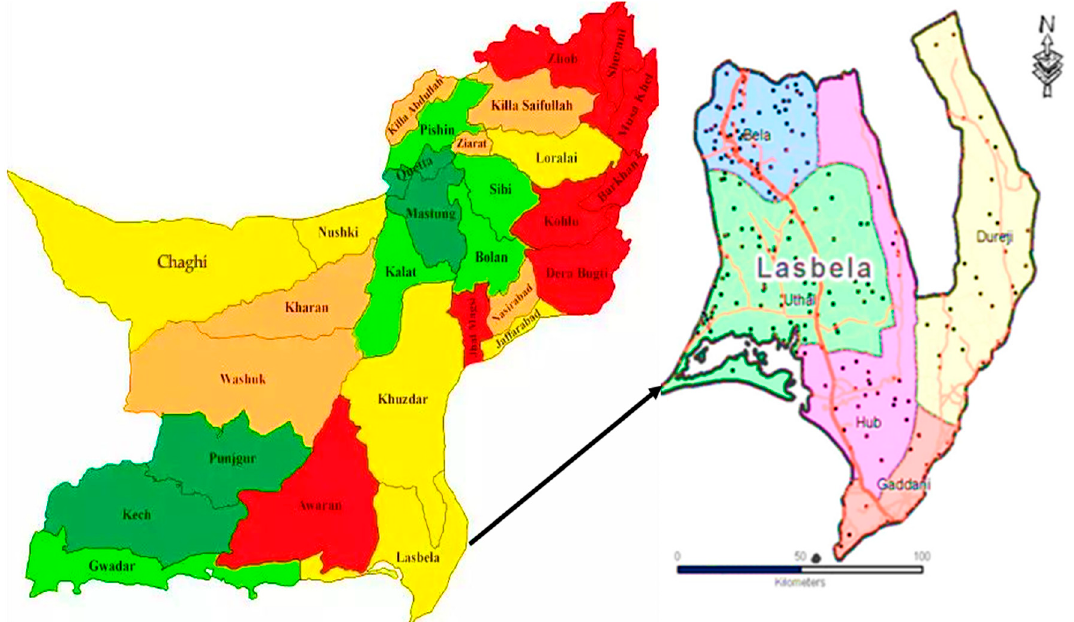
Figure 1. Map showing the research area of Lasbela, coastal region of Baluchistan, Pakistan.